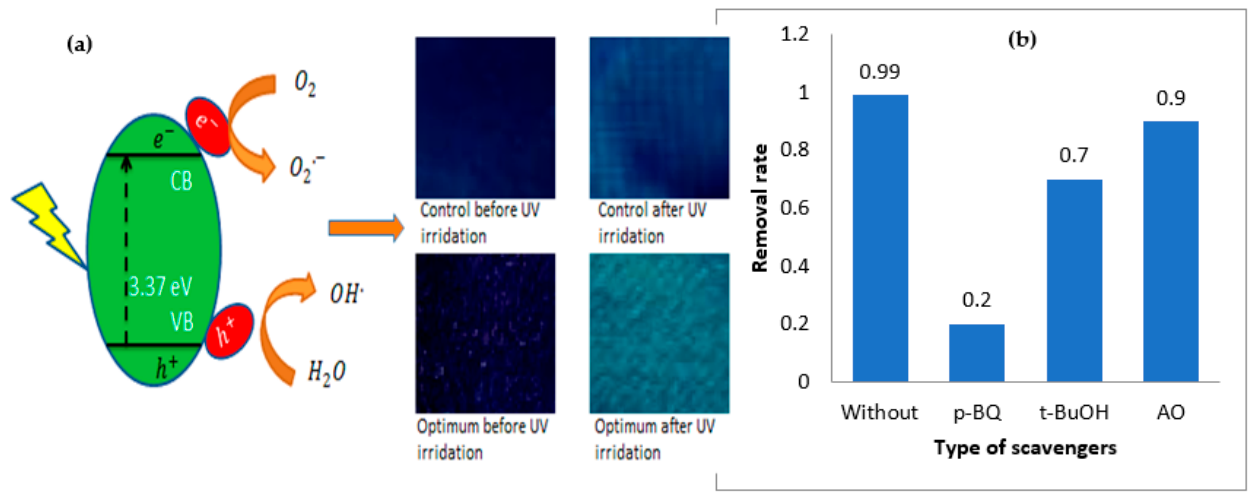
Figure 3. ( a ) Mechanism of photodegradation of MB on ZnO-coated fabric with a color difference of optimum and control samples before and after 6 h of UV irradiation and ( b ) removal rate of methylene blue in the presence of different scavengers.